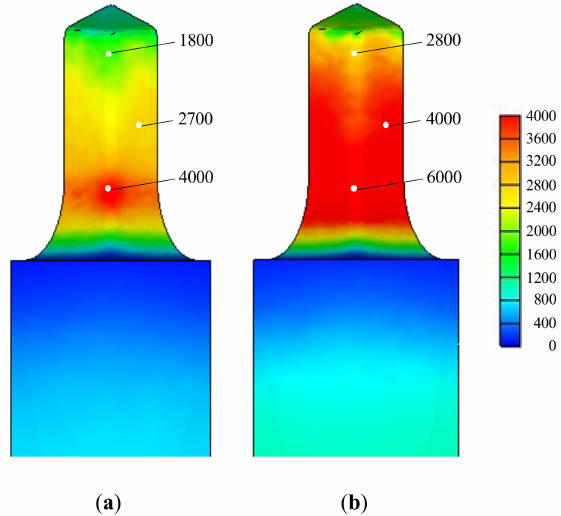
Figure12. E ff ectivestresses(MPa)onthelowerdiepartatthefifthstage, ascalculatedvianon-isothermal and isothermal analyses: ( a ) Non-isothermal; ( b ) Isothermal.